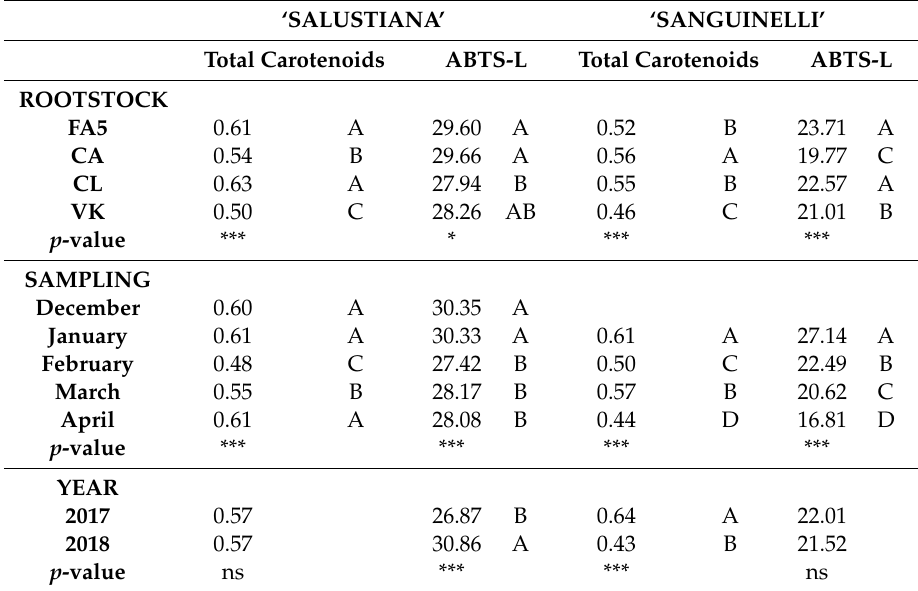
Table 5. E ff ect of rootstock, sampling date, and year on total carotenoids and antioxidant activity (ABTS-L) in ‘Salustiana’ and ‘Sanguinelli’ cultivars. ABTS-L is expressed in mg TE / 100 g FW and total carotenoids in mg β C / 100 g FW.